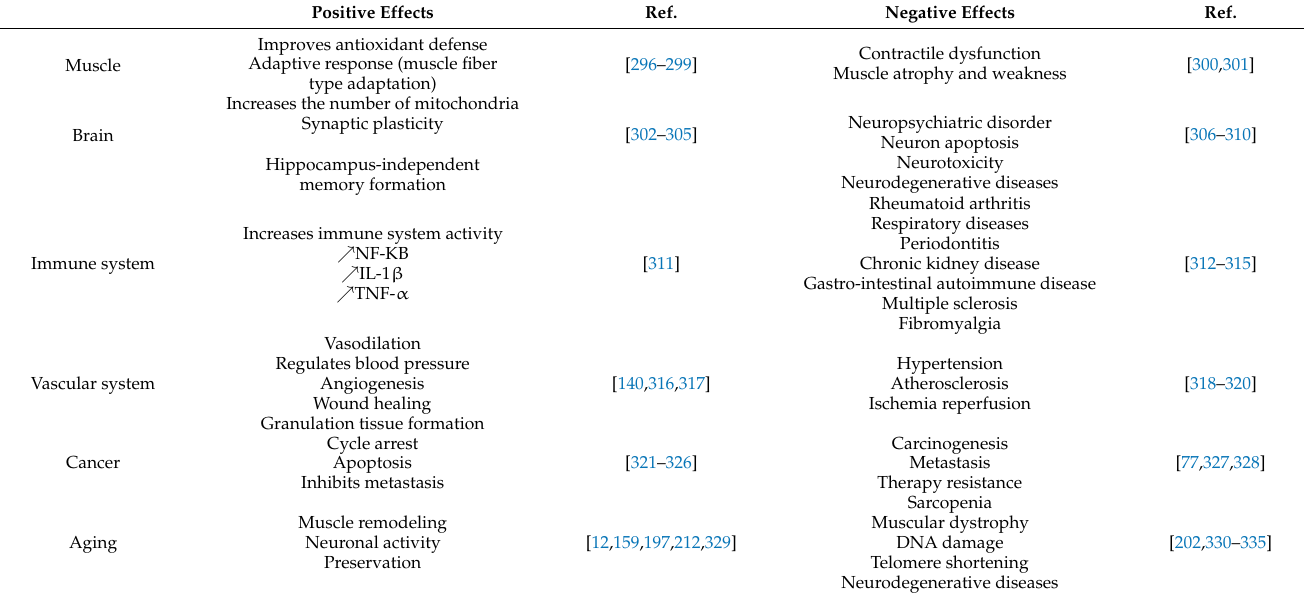
Table 2. Positive and negative effects related to the generation of oxidative stress on organs, systems, diseases, and physiological